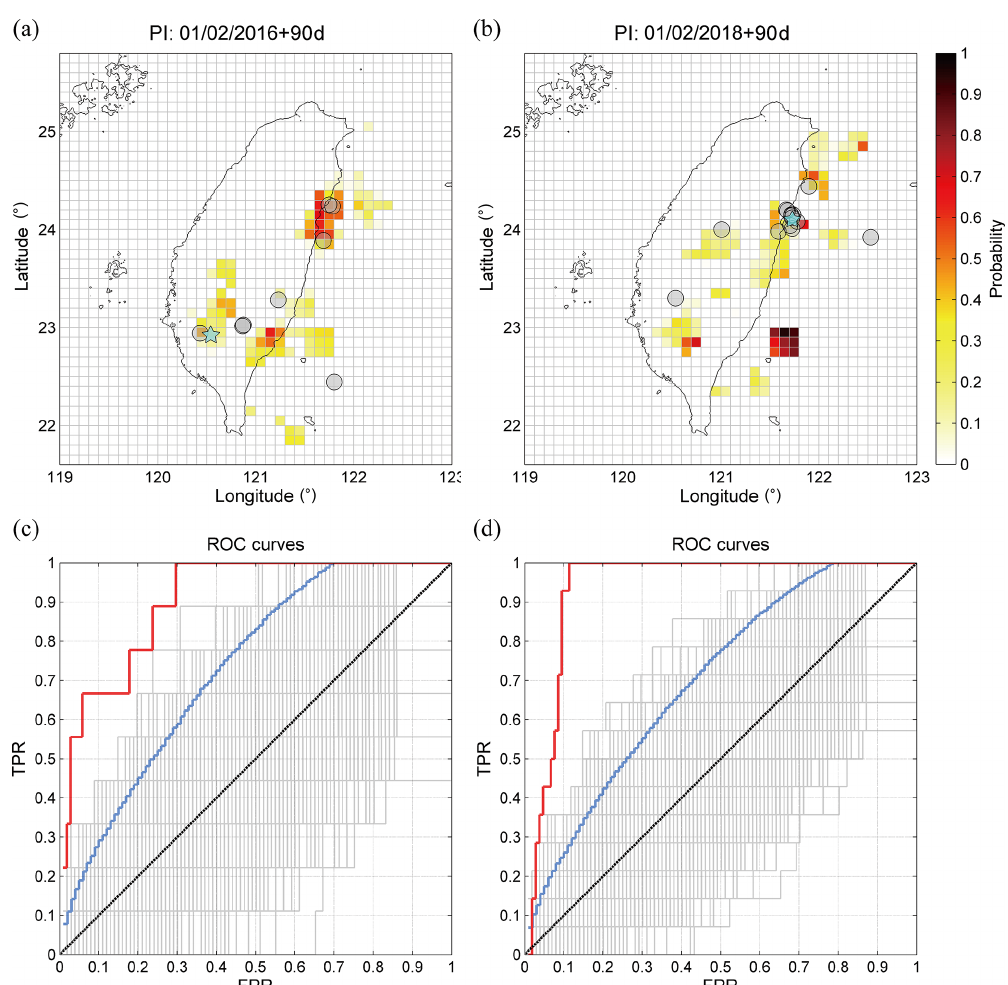
Figure 1. Panels (a) and (b) show the forecasting probability maps of the Meinong earthquake and the Hualien earthquake, respectively. Panels (c) and (d) are the ROC curves of (a) and (b) , respectively. Red, gray, blue, and black curves represent the forecasting probability map, random tests, 95% confidence interval, and the average of random tests,